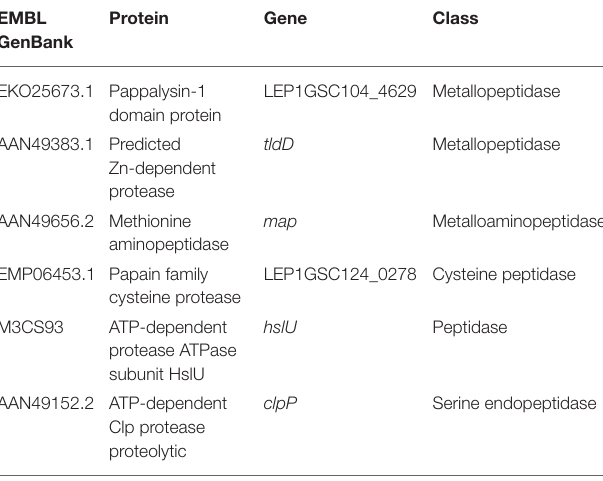
TABLE 1 | Proteases identified in the L. interrogans serovar Kennewicki strain Fromm (LPF) exoproteome. EMBL